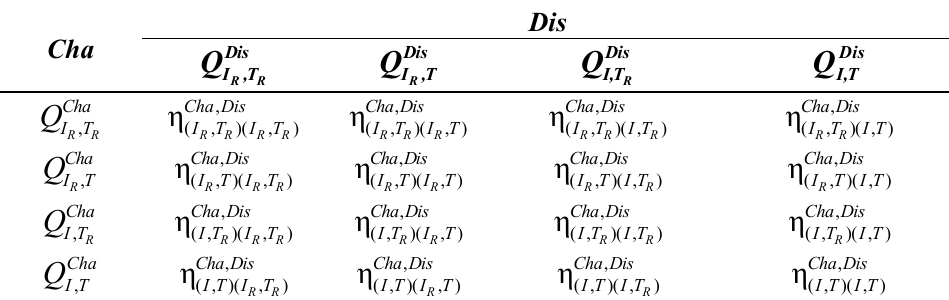
Table 3. Coulombic efficiency at different